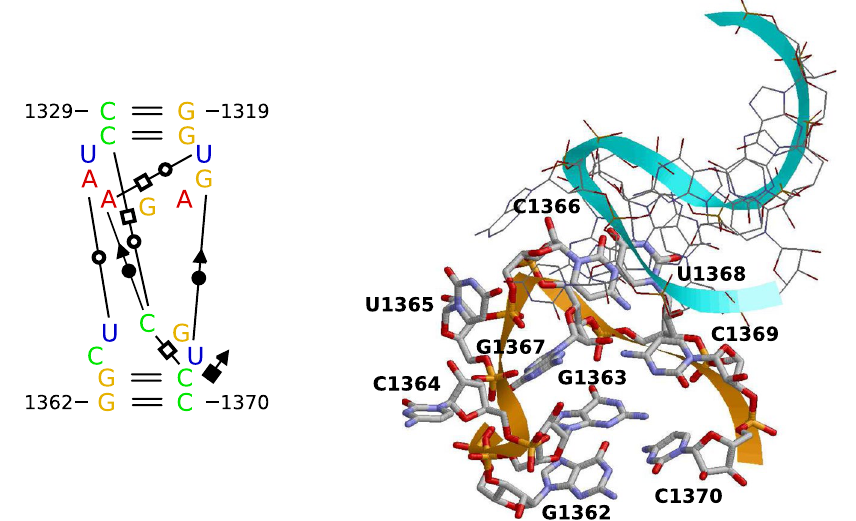
Figure 8. View on kissing-loop interaction. The nucleotides 1319–1329 and 1362–1370 from PDB entry 3J3W are visualized by rnaview (left) and by RasMol (right). The hairpin loop 1363–1369 is identical in sequence to the standard hairpin loop of